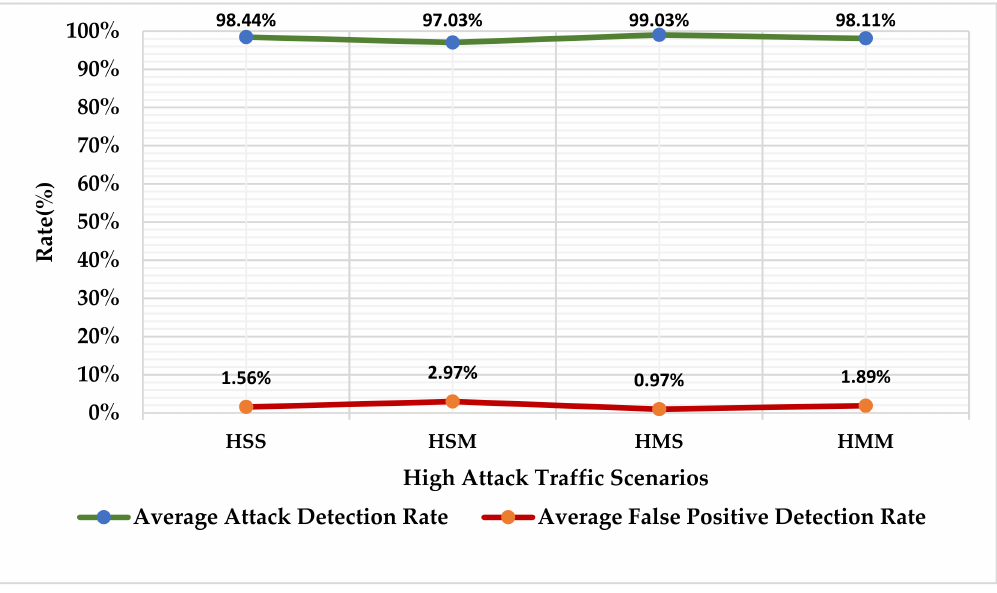
Figure 5. Average DR and FPR of each high-rate DDoS attack traffic